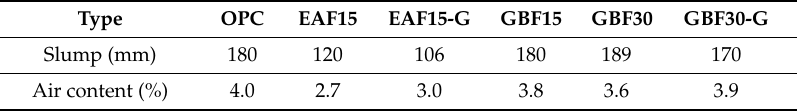
Table 3. Results of slump and air content.